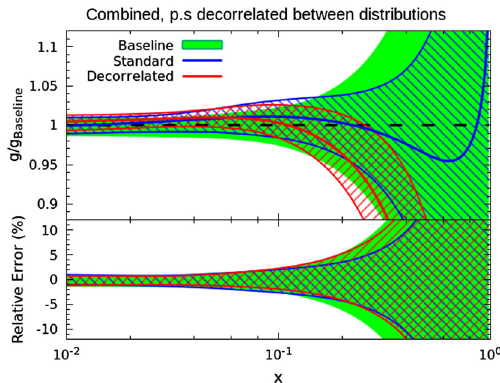
Fig. 3 Impact of the ATLAS 8 TeV lepton + jet data on the gluon PDF. The result of the default to the combined dataset is shown, as well as decorrelating the parton shower systematic uncertainty between the four distributions